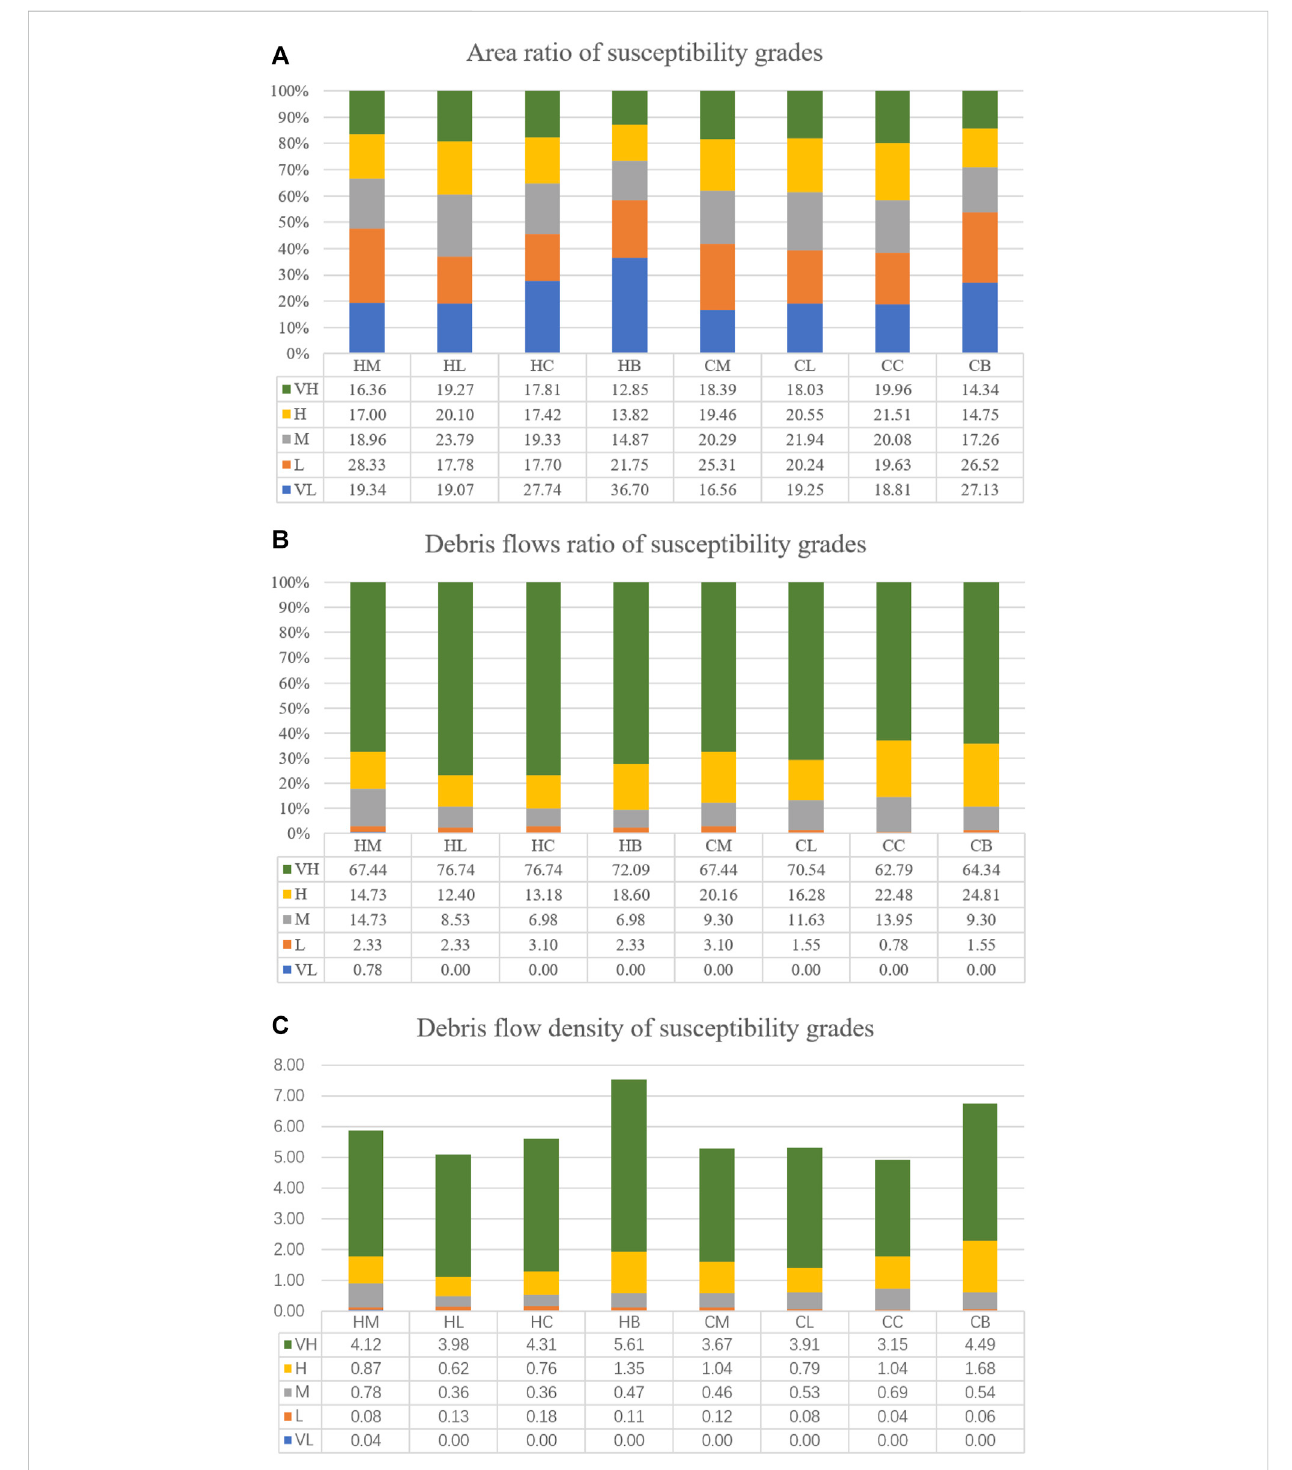
FIGURE 9 The classi fi cation of DFSMs and debris fl ow density: (A) area ratio; (B) debris fl ows ratio; (C) debris fl ow density.